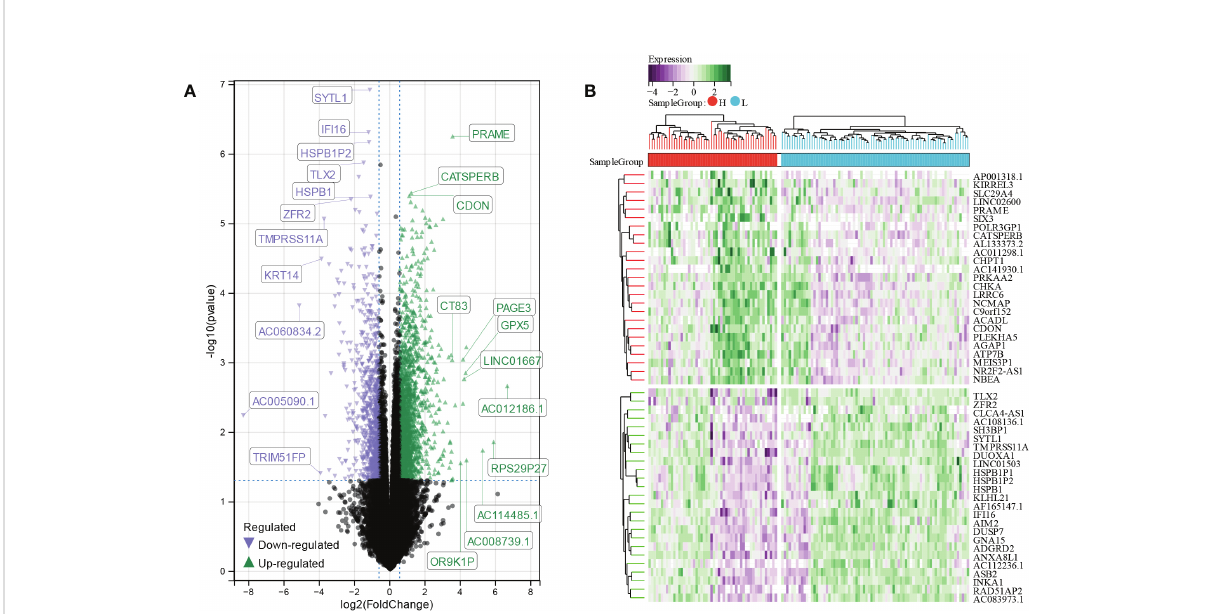
FIGURE 4 Identi fi cation of E6 splicing DEGs in CESC (A) The volcano plot of all DEGs in high and low E6ratio TCGA-CESC patients. The differences are set as p value<0.05 and log FCI >1.5 (B) Heatmap showing 50 signi fi cantly DEGS of high and low E6ratio TCGA-CESC